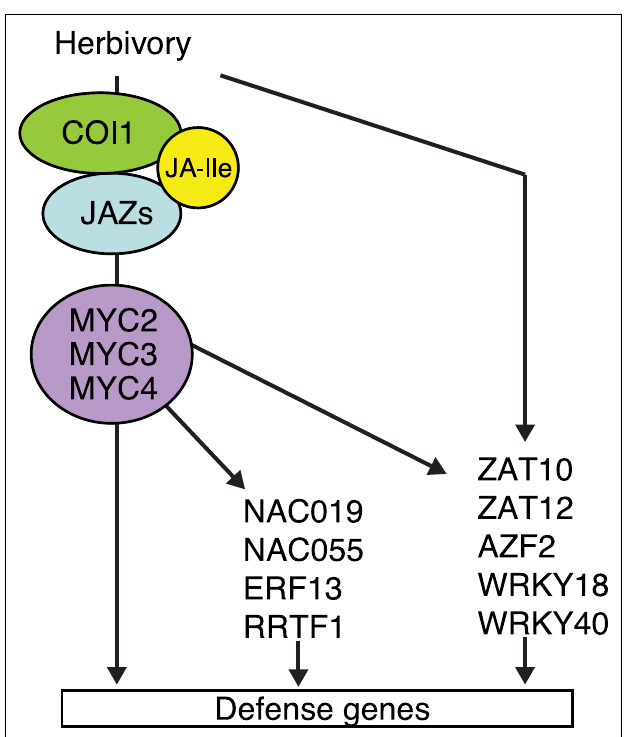
FIGURE 7 |A model for the transcriptional network in defense against chewing insects. In response to herbivory, plants produce JA-Ile.This hormone is detected by its receptor COI1 that in turn degrades JAZ repressors (not shown) to allow the transcriptional activity of MYC2, MYC3, and MYC4TFs. As a consequence, MYCs activate the expression defense genes and downstreamTFs. In addition, herbivory induces the expression of severalTFs, which partially depend on COI1 and MYCs. How theseTFs are regulated and which are their target genes remains unknown.This model only containsTFs described in this